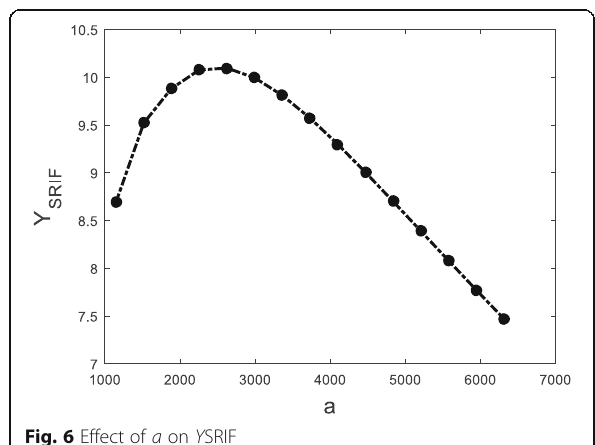
Fig. 6 Effect of a on Y